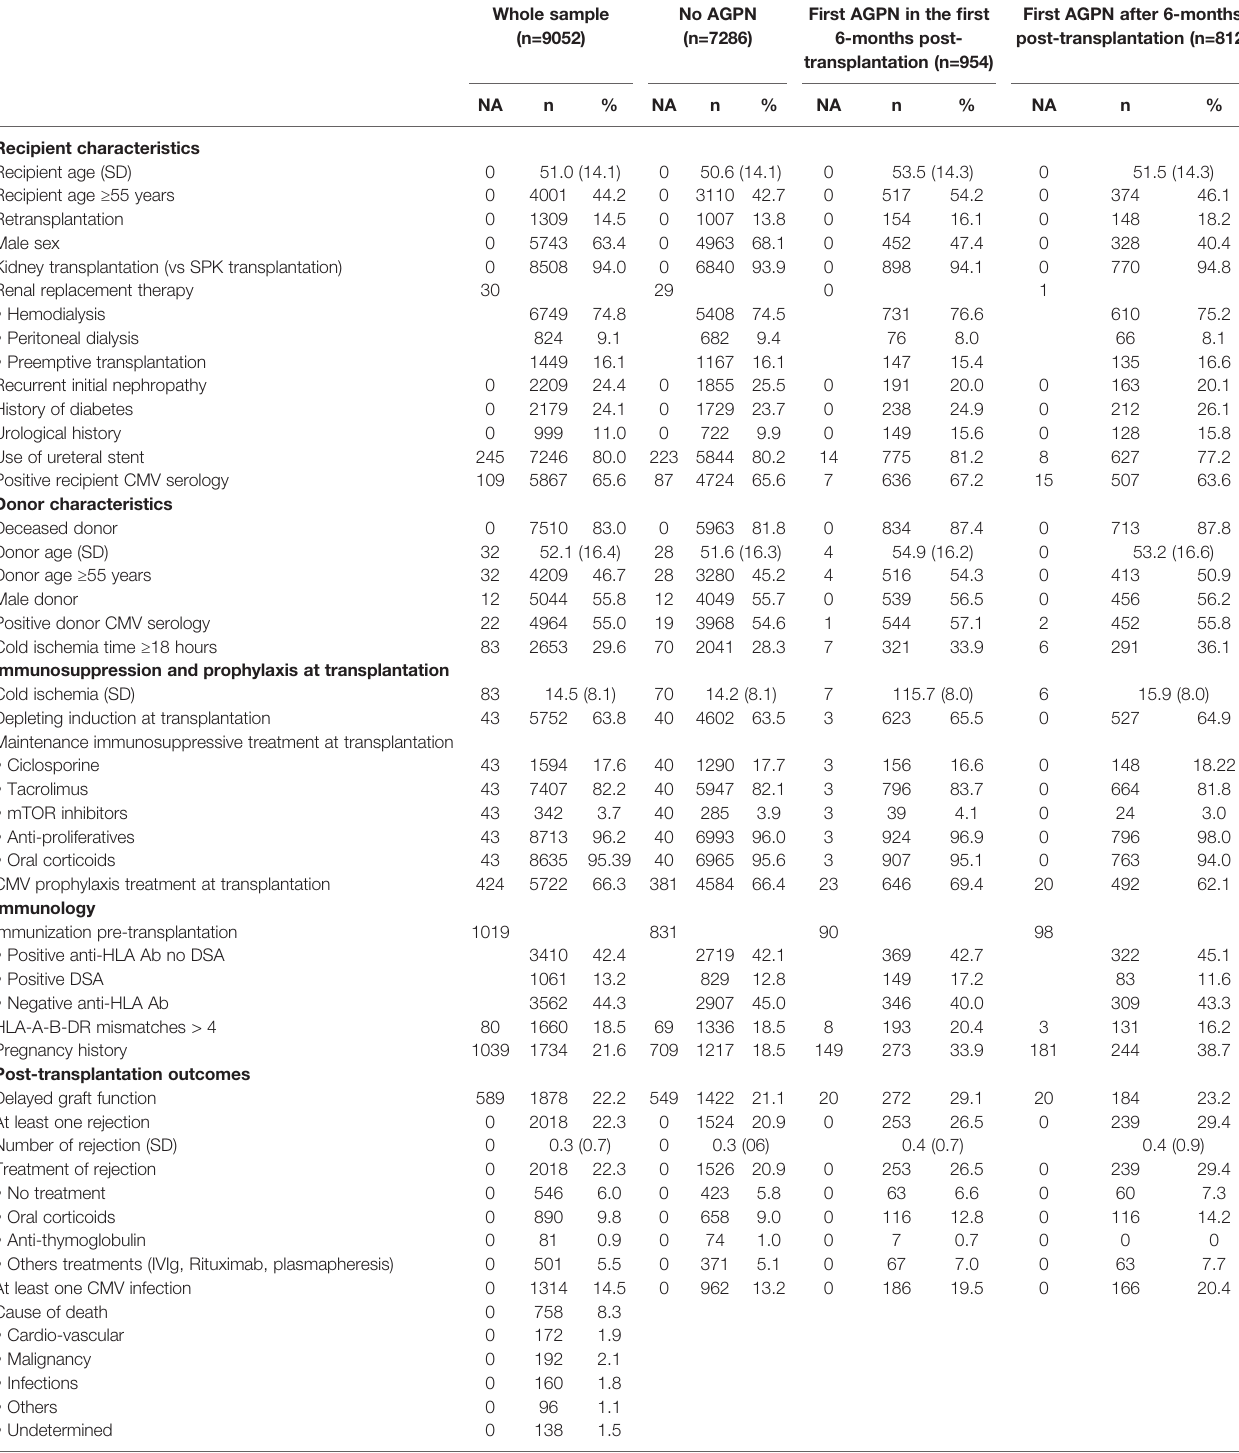
TABLE 1 | Characteristics of 9052 transplant recipients included in the